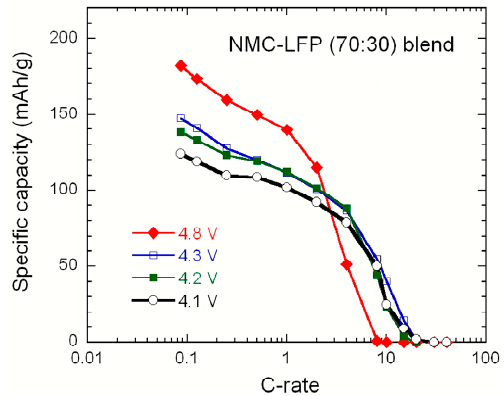
Figure 10. Specific capacity of the NMC–LFP (70:30) blended electrode as a function of C-rate in lithium cells cycled at different cut-off